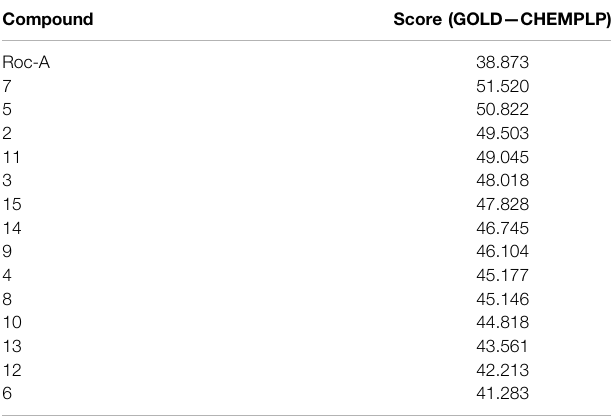
TABLE 3 | Compounds from the training set ranked according to their corresponding docking score values, predicted using the CHEMPLP scoring function by GOLD software.